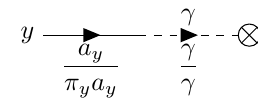
γ 0 Figure 6. Diagram for interaction x −→